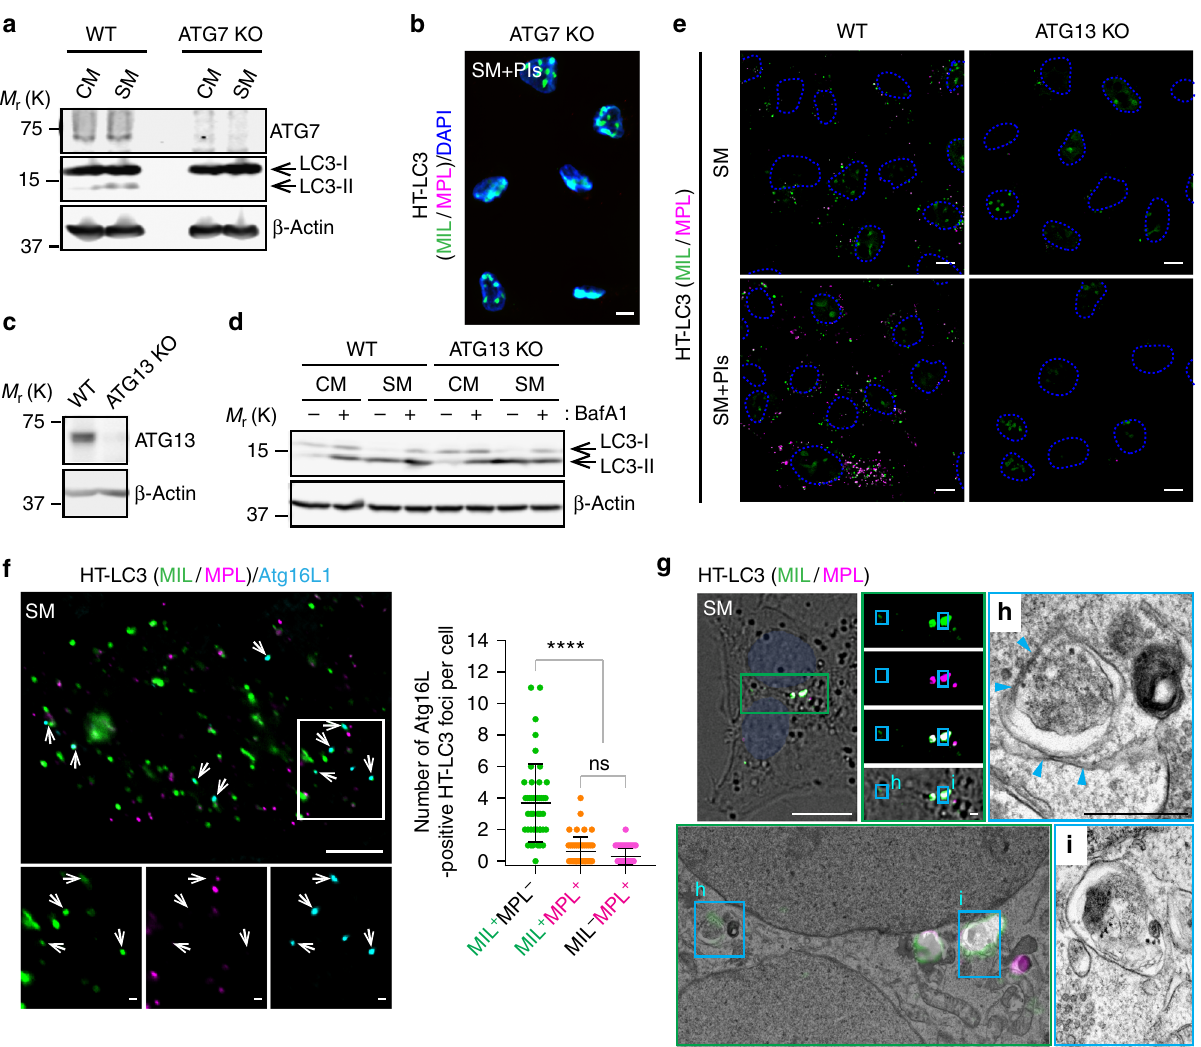
Fig. 2 The cytoplasmic HT-LC3 positive foci speci fi cally represent autophagic structures. a ATG7-de fi cient U-2 OS cells were generated using the Crispr- Cas9 gene editing system and subjected to starvation for 3 h followed by immunoblotting using the indicated antibodies. b ATG7-de fi cient HT-LC3 U-2 OS cells were starved in the presence of lysosomal protease inhibitors (PIs) and subjected to the HT-LC3 autophagosome completion assay followed by deconvolution fl uorescence microscopy. c , d ATG13-de fi cient U-2 OS cells were generated using the Crispr-Cas9 gene editing system. The resultant cells were subjected to immunoblotting using the indicated antibodies ( c ) or starved in the presence or absence of 100 nM BafA1 followed by immunoblot analysis ( d ). e ATG13-de fi cient HT-LC3 U-2 OS cells were starved in the presence or absence of PIs and subjected to the HT-LC3